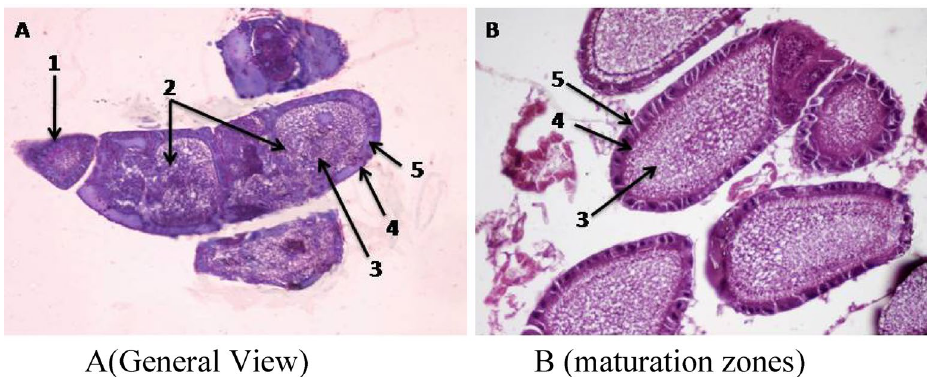
Figure 1. (A,B) . Cross section in the ovariole of normal (unirradiated) female Ephestia cautella (×400). 1, Germarium zone; 2, oocytes; 3, nurse cells; 4, epithelial cells; 5, follicular